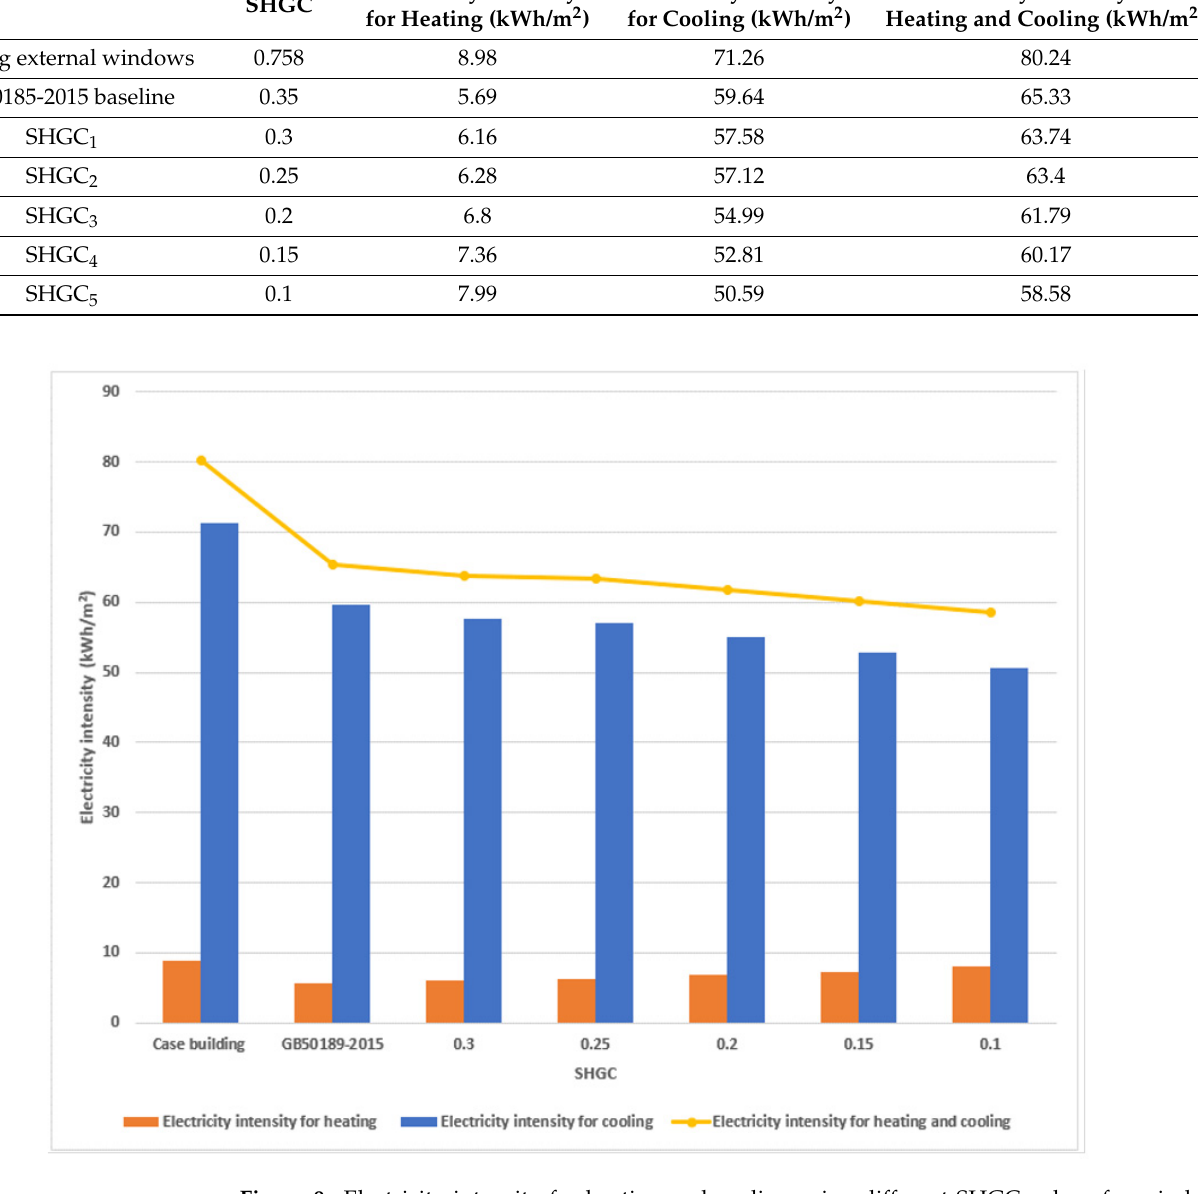
Figure 9. Electricity intensity for heating and cooling using different SHGC values for window energy retrofitting.